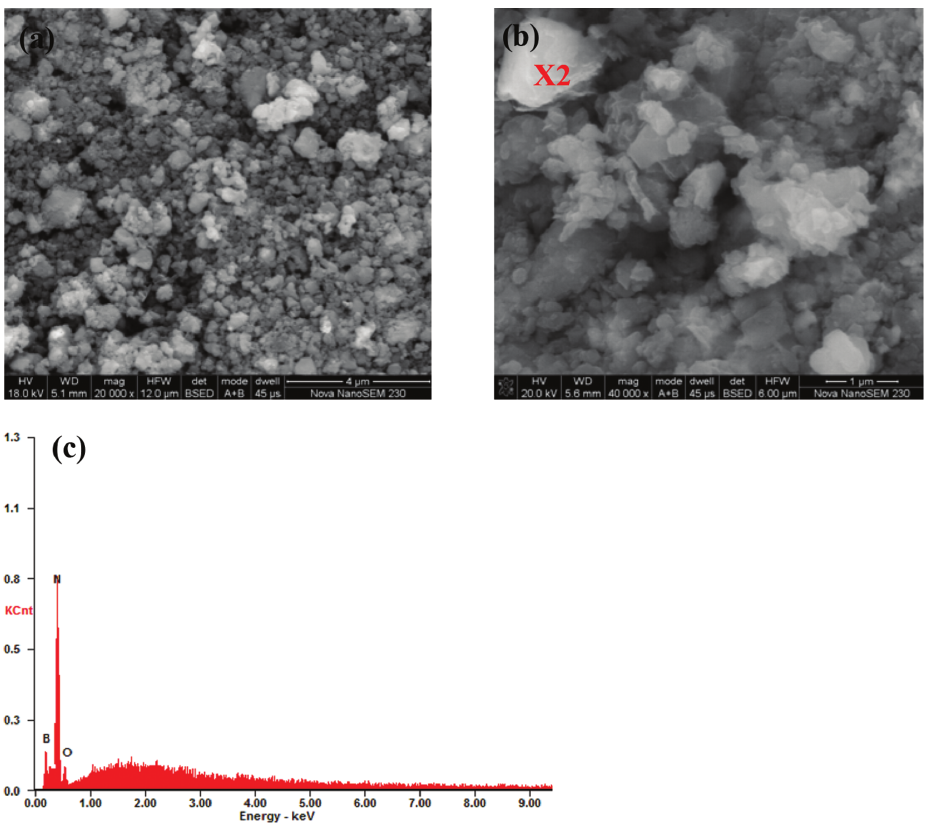
Figure 8: (a) SEM of Si 3 N 4 /BN(CB) composite ceramics; (b) SEM of high magnification of Si 3 N 4 /BN(CB) composite ceramics and (c) (EDS) analysis at